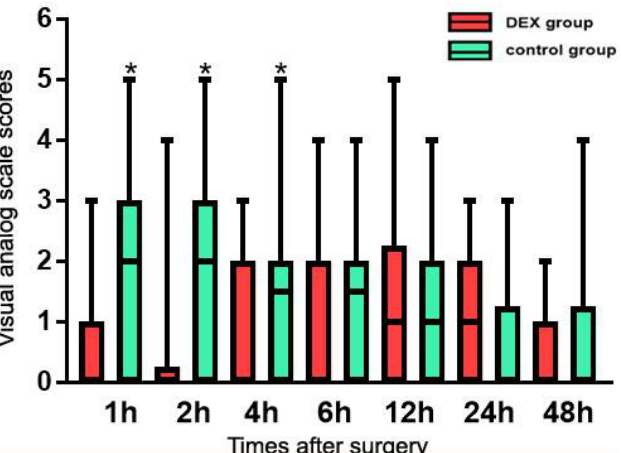
Figure 2. Postoperative pain scores. Notes: DEX, dexmedetomidine; Values are present as mean ± SD. * p < 0.05, compared with Dex group. Table 2. Incidence of postoperative moderate to severe pain and dosage of